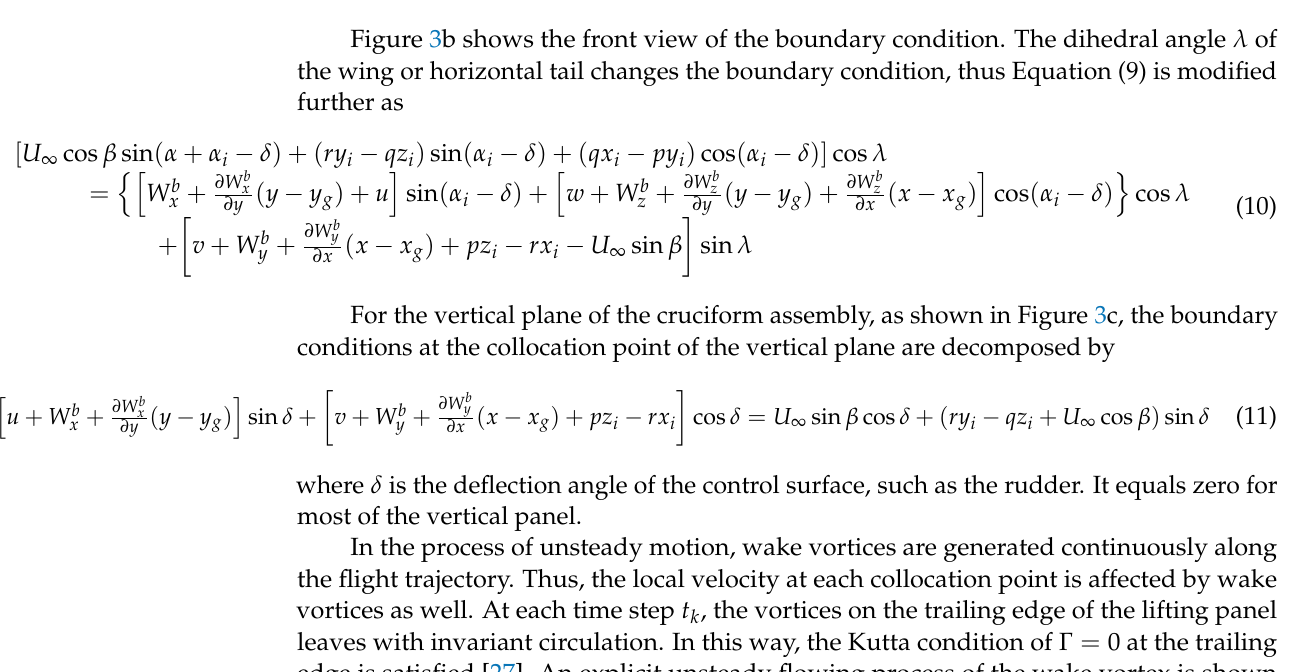
Figure 3. Decomposition of the turbulent boundary conditions: ( a ) the side view of the boundary condition for the horizontal lifting panel. ( b ) the front view of the boundary condition. ( c ) the boundary condition for the vertical plane of the cruciform